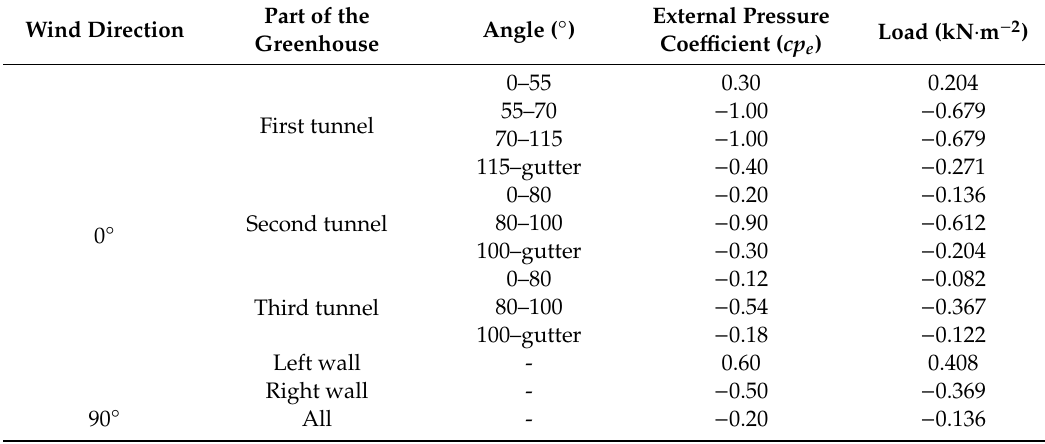
Table 1. External pressure coe ffi cient and wind load values for 0 ◦ and 90 ◦ wind directions. Wind